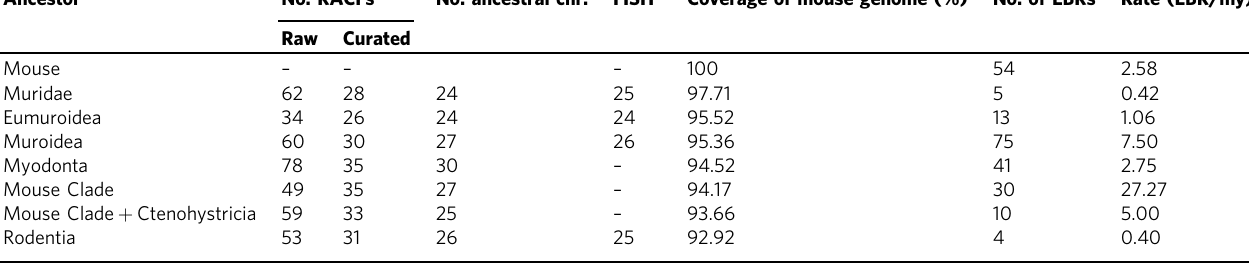
Table 1 Summary statistics of the reconstructed ancestral chromosome fragments (RACFs) and evolutionary breakpoint regions (EBRs) in the seven rodent ancestors and